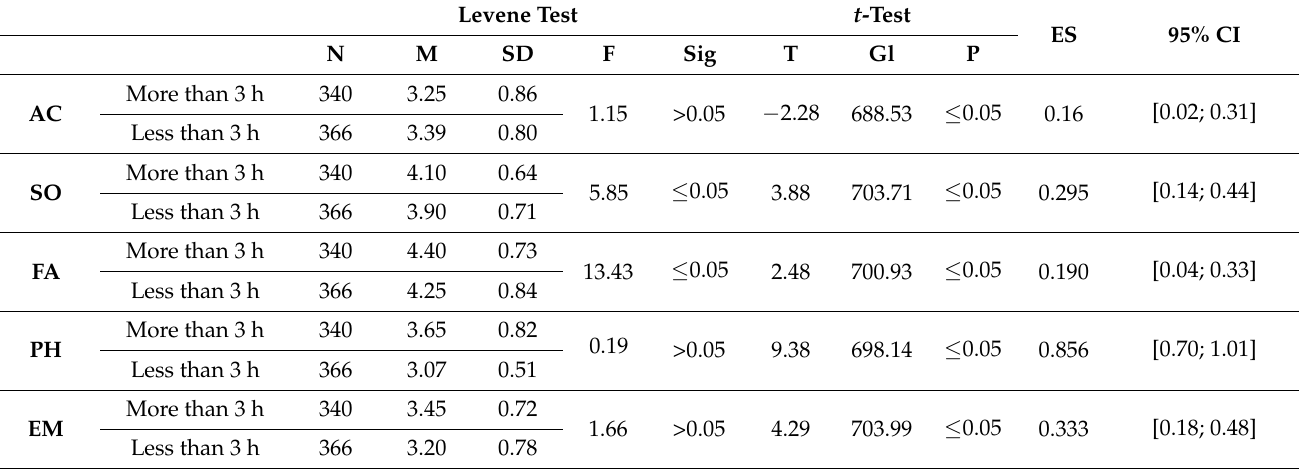
Table 1. Comparative study of the sample according to the physical activity time per week. Levene Test t